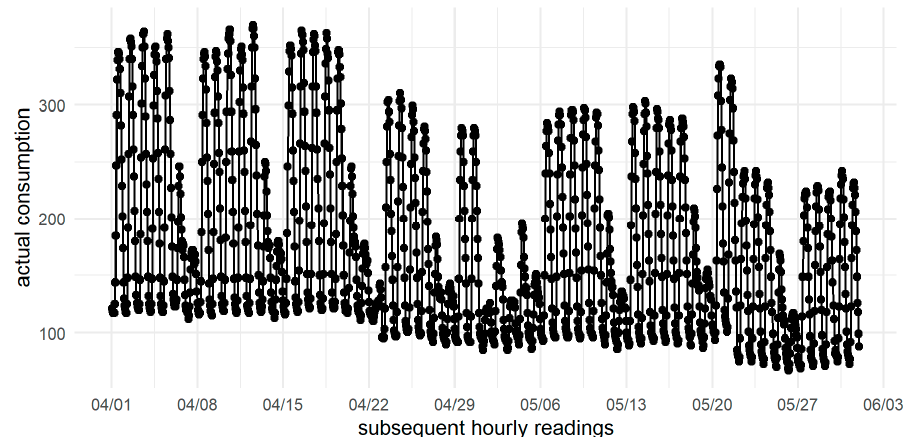
Figure 10. Actual consumption series for PPE-Example4. Source: own elaboration.